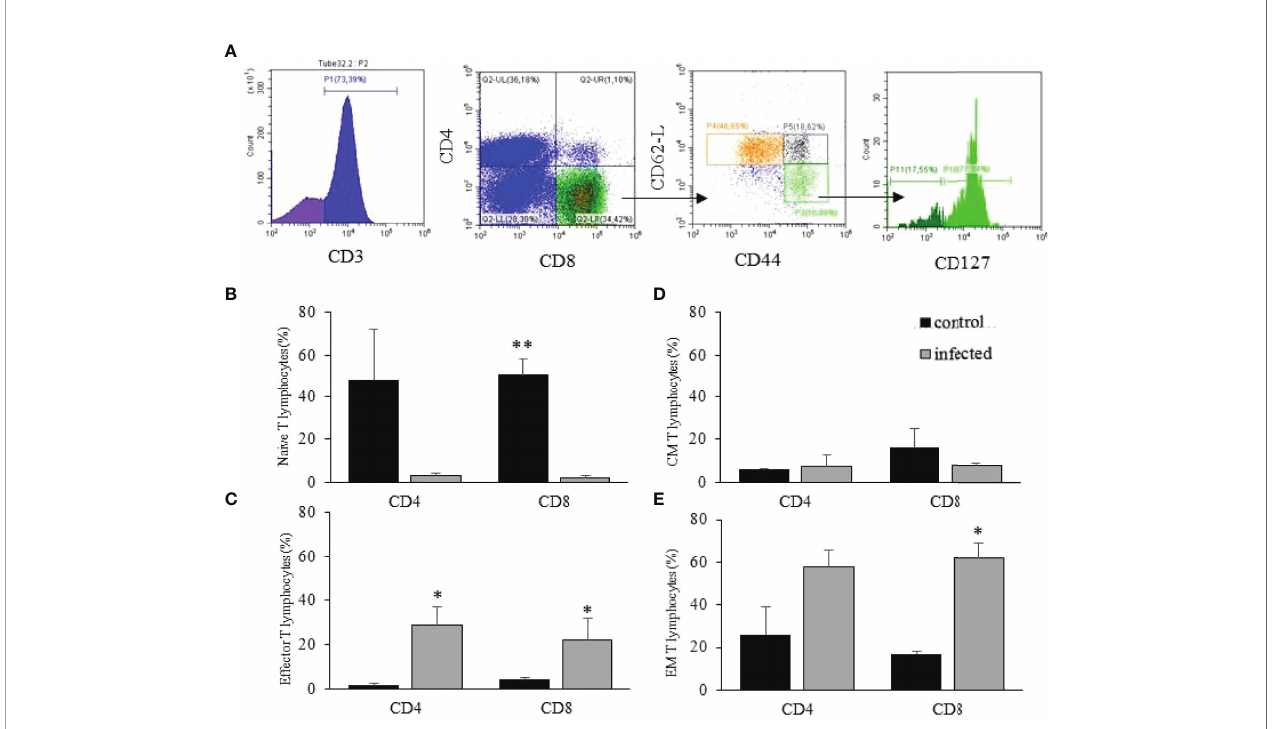
FIGURE 4 | Intrahepatic T lymphocytes after T. cruzi infection. The fl ow cytometry data analysis was done for CD4 + and CD8 + T lymphocytes (illustrated in A) in the gate of CD3 + events. The gating strategy is shown for EM and effector cells using an infected mouse (A) . Then, for each population, the frequency of naïve (CD62L + CD44 low ); effector (CD62L - CD44 high CD127 - ), EM (CD62L - CD44 high CD127 + ); and CM T lymphocytes (CD62L + CD44 high ) was analyzed (A) . The distribution of naïve (B) , effector (C) , CM (D) , and EM (E) T lymphocytes in the liver of control and infected mice on dpi 15 are shown. * means p ≤ 0.05 and ** means p ≤ 0.005 using the one-way ANOVA test followed by Tukey ’ s